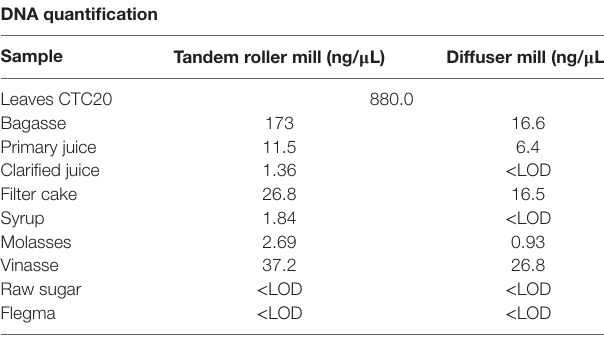
TaBle 12 | DNA quantification for each processing fraction sample from two types of mills.